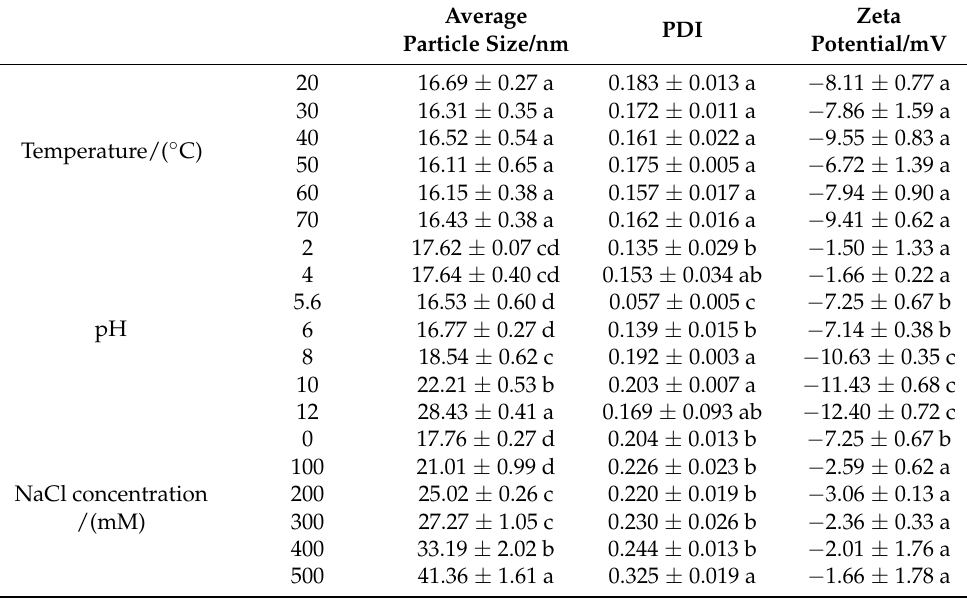
Table 2. The effect of different factors on the stability of GMEs. Different letters (a,b,c,d) in the same column indicate that there is a signifcant difference between each condition group. ( p < 0.05). Average Particle